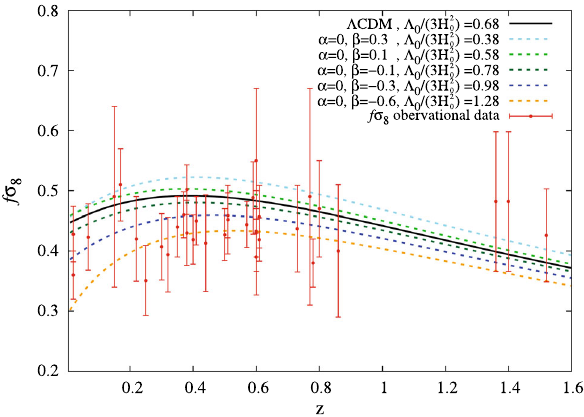
Fig. 6 f σ 8 as a function of z in our model and (cid:2) CDM, where (cid:15) (cid:2) is fixed to be